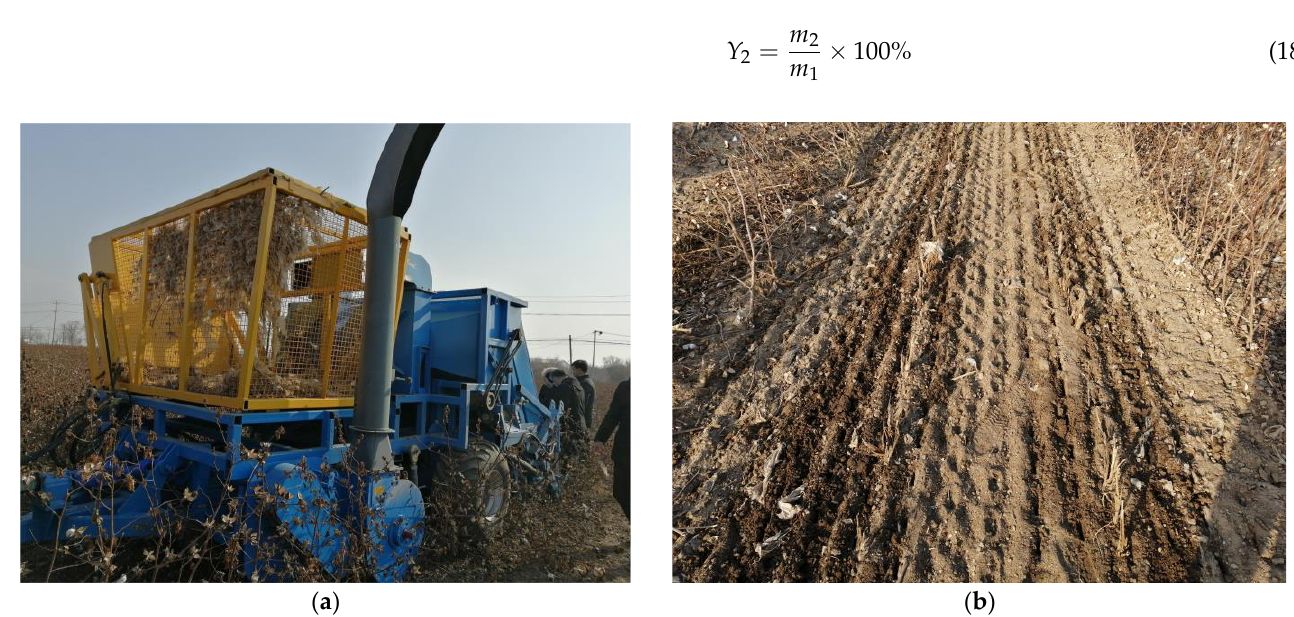
Figure 10. ( a ) Field performance test of SRPFC; ( b ) effect of RPF recovery.